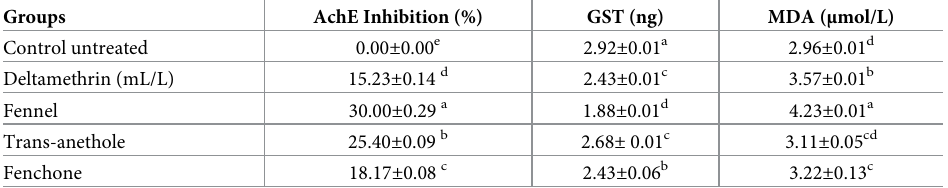
AchE = acetylcholinesterase, GST = glutathione- S-Transferase, MDA = malondialdehyde. Means within the same column followed by different superscripts are significantly different (Duncan’s multiple range test: P �